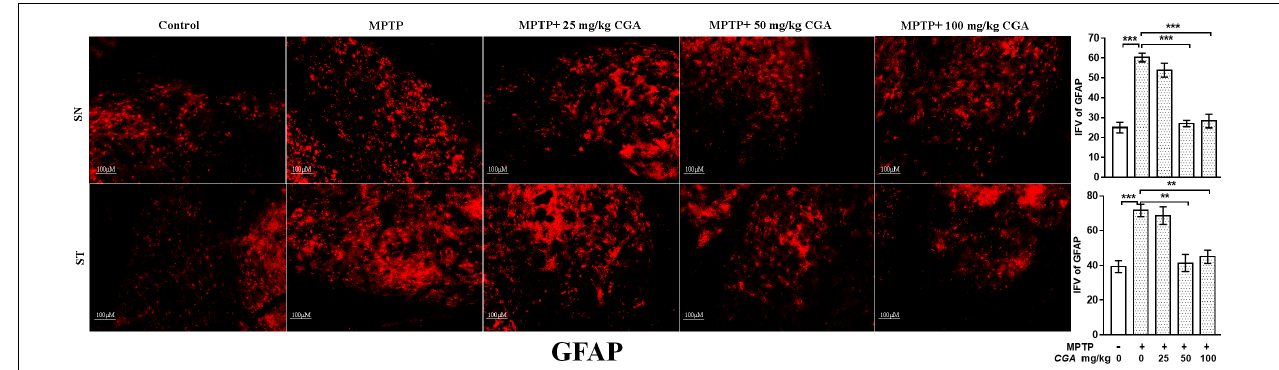
FIGURE 6 | IHC of glial fibrillary acidic protein in the SN and striatum of mice. With 10 × magnifications after staining. The expression of GFAP-positive astrocytes was significantly increased in the SN and striatum of MPTP-injected mice compared with the control group, whereas CGA treatment decreased the expression of GFAP-positive astrocytes in MPTP+CGA group compared with the MPTP group. ∗ p < 0.05, ∗∗ p < 0.01, and ∗∗∗ p < 0.001. CGA, chlorogenic acid; MPTP, 1-methyl-4-phenyl-1,2,3,6-tetrahydropyridine; SN, substantia nigra; ST, striatum; GFAP, glial fibrillary acidic protein; SEM, standard error of mean; IFV, integrated fluorescent